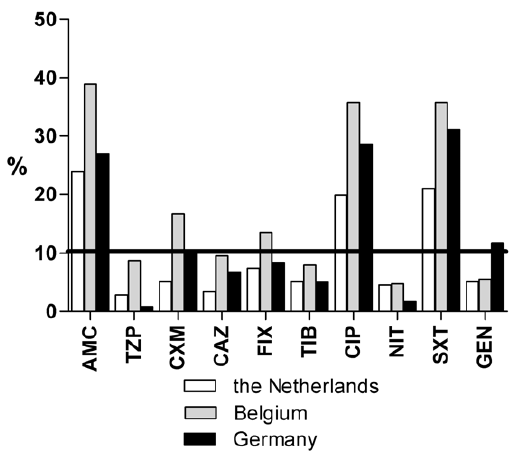
Figure 2. Antibiotic resistance and suitability of antibiotics for empiric treatment. Antibiotic resistance for the different antibiotics among the three groups of isolates compared with a 10% resistance cutoff to decide whether an antibiotic agent is suitable for empiric treatment. AMC = amoxicillin-clavulanic acid, TZP = piperacillin- tazobactam, CXM = cefuroxime, CAZ = ceftazidime, FIX =